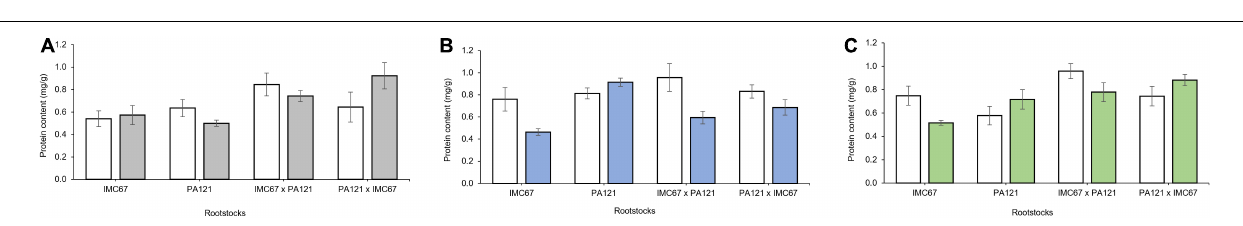
FIGURE 12 | Protein content in leaf tissue of rootstocks and grafting combinations subjected to two different concentrations of Cd in soil under greenhouse conditions. (A) Protein content in leaf tissue of ungrafted seedling families 5 months after Cd addition. (B) Protein content in leaf tissue of the ICS95 clonal scion 2 months after grafting with four different rootstock families. (C) Protein content in leaf tissue of the CCN51 clonal scion 2 months after grafting with four different rootstock families. White bars represent families grown in soil without addition of Cd (0.43 mg kg − 1 ). Gray bars represent ungrafted seedling families grown in Cd-spiked soil (7.49 mg kg − 1 ). Blue bars represent seedling rootstock families grafted with the ICS95 clonal scions in Cd-spiked soil (7.49 mg kg − 1 ). Green bars represent seedling rootstock families grafted with the CCN51 clonal scion in Cd-spiked soil (7.49 mg kg − 1 ). Data are mean values ± SE (n =